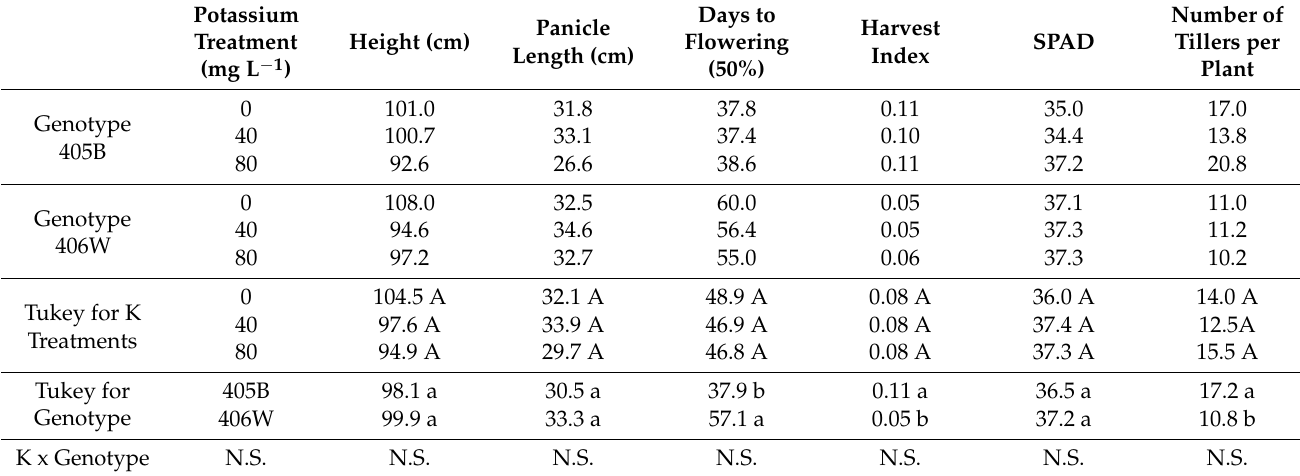
Table 4. Effect of K fertigation levels on growth parameters in the summer field experiment. Different letters represent significant (<0.05) differences for main effects. Upper case letters next to the values in the 3rd row represent the results of the Tukey test for nutrient concentration averaged across genotypes, and lower case letters next to the values in the 4th row represent the results of the Student- t test for the two different